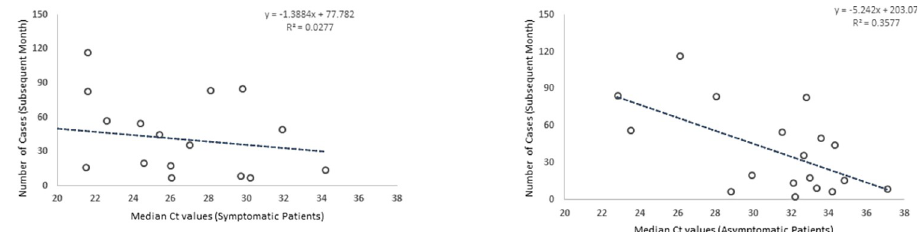
Fig 3. Correlation between Ct values from symptomatic and asymptomatic patients and the number of cases in the subsequent months. (a) Correlation between Ct values for symptomatic patients with the number of positive cases in the subsequent months (r = -0.167, p < 0.05). (b) Correlation between Ct values for asymptomatic patients with the number of positive cases in the subsequent months (r = -0.598, p < 0.05).